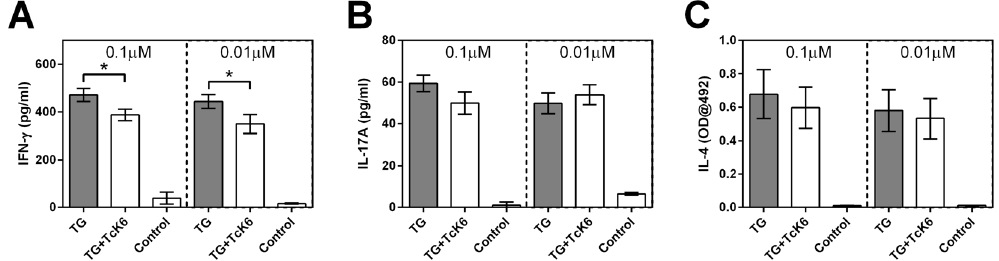
Figure 5. TcK6-mediated inhibition of cytokine production from activated ovine PBMC. Ovine PBMC isolated from 4 adult helminth-free sheep were stimulated in triplicate wells with thapsigargin (TG) in the presence or absence of 0.1 µ M or 0.01 µ M TcK6 (indicated in each graph) and the levels of ( A ) IFN- γ , ( B ) IL-17A and ( C ) IL-4 released into the culture supernatant quantified by ELISA. Addition of both concentrations of TcK6 significantly reduced the levels of IFN- γ released by TG-stimulated PBMC but had no effect on release of IL- 17A or IL-4. P-values from two-tailed Mann-Whitney t-tests are indicated for statistically significant differences between TG stimulated cells with or without TcK6 (n = 12). Control = PBMC without TG or TcK6 stimulation. * = P <